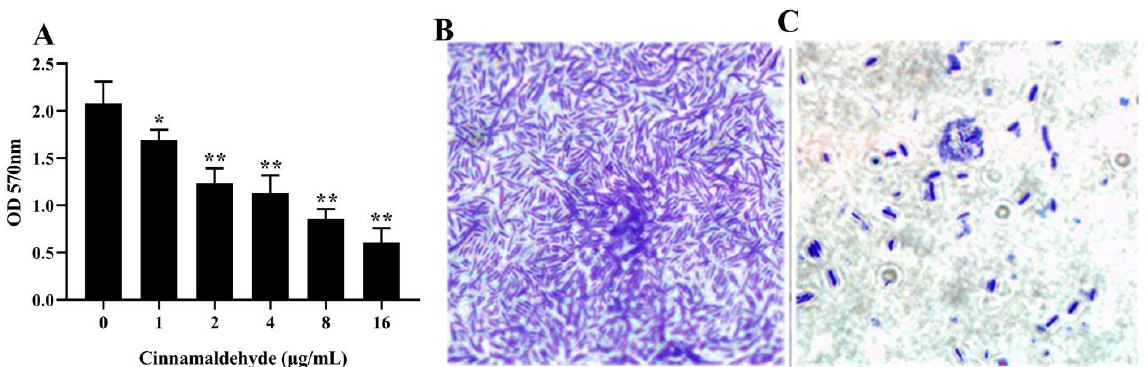
Figure 4. Effect of cinnamaldehyde on biofilm formation of A. hydrophila . ( A ) Determination of the cinnamaldehyde effect on bacterial biofilms, all data are the mean ± SD of three independent experiments. *, 0.01 < p < 0.05 and **, p < 0.01 when compared with drug-free group; ( B ) cinnamaldehyde-free group; ( C ) 16 μg/mL.